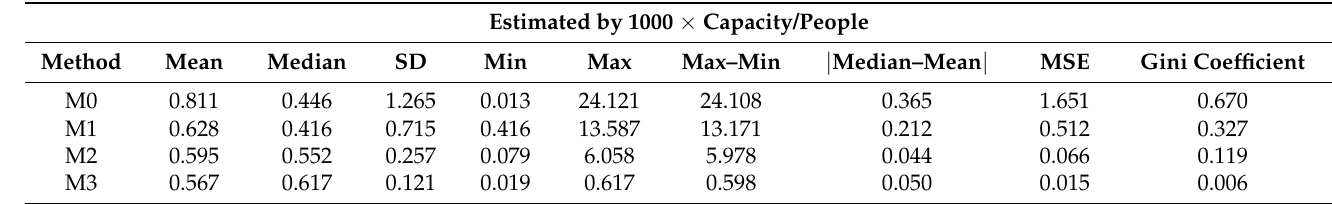
Table 5. Measures of geographical inequality of community care resources through methods M0–M3 (national level).